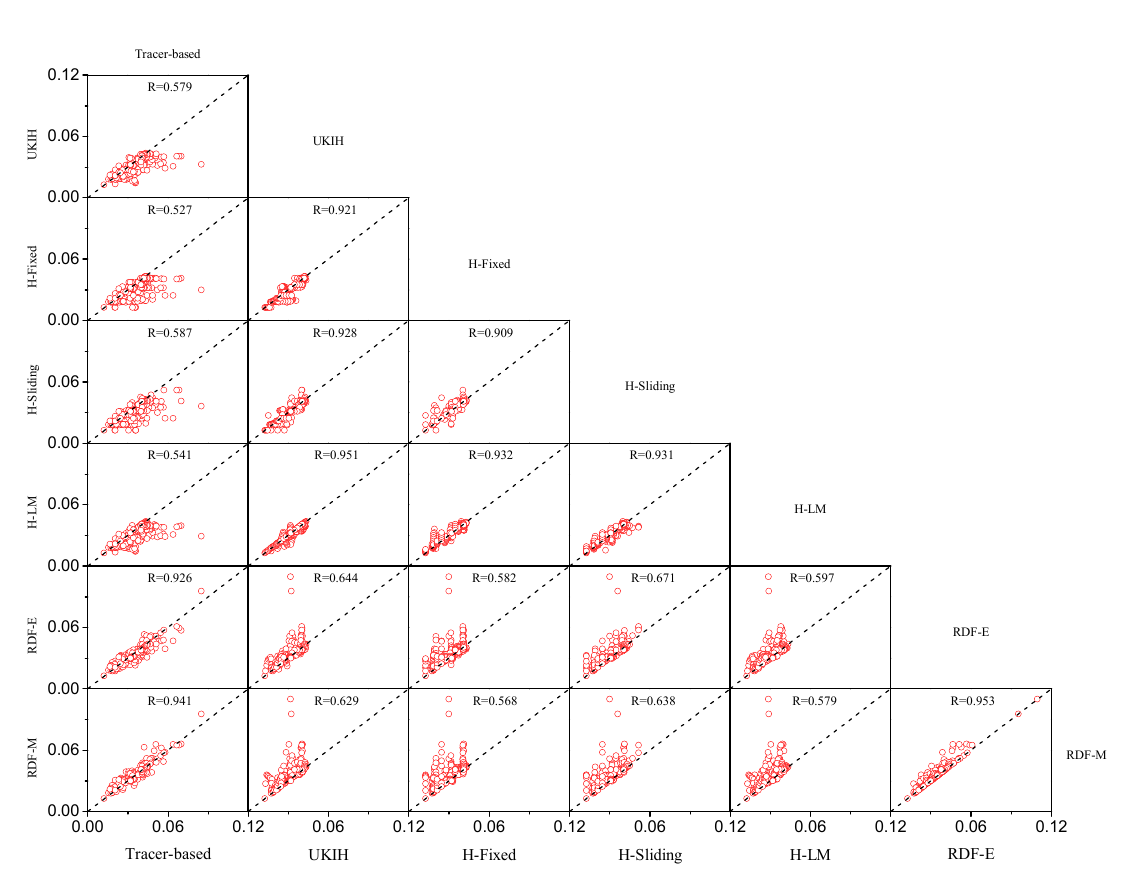
Figure 9. The distribution of daily BFI obtained by di ff erent automatic baseflow separation methods in Figure 9. Scattered comparison of baseflow obtained by different baseflow separation methods. the dry season and rainy season. Table 3. The performance of di ff erent baseflow separation Table 3. The performance of different baseflow separation methods.